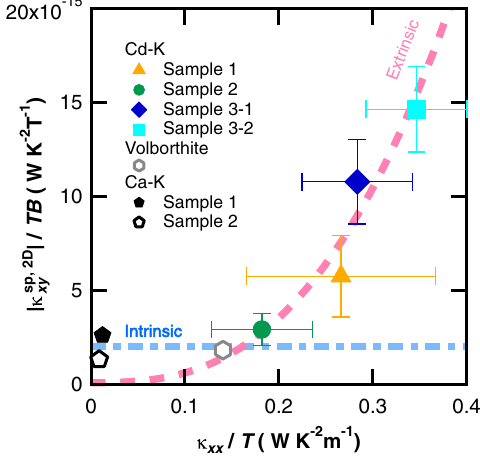
FIG. 13. The spin thermal Hall conductivity per the 2D kagome layer j κ sp ; 2 D xy j =TB of Cd-K, Ca-K [26], and volborthite [25] plotted as a function of the longitudinal thermal conductivity κ =T at 0 T. The value of κ =T is taken at the peak temperature xx xx =TB for Cd-K (4 – 6 K; see Fig. 12) and that of j κ 2 D =TB for of δκ xy xy j Ca-K and volborthite (16 K). The error bars represent the ambiguity in estimating the absolute value of κ and κ owing xx xy to the nonrectangular shape of the samples (see Supplemental Material [51] for details). The blue and pink dashed lines are guides to the eye for the intrinsic and extrinsic contributions, respectively (see the main